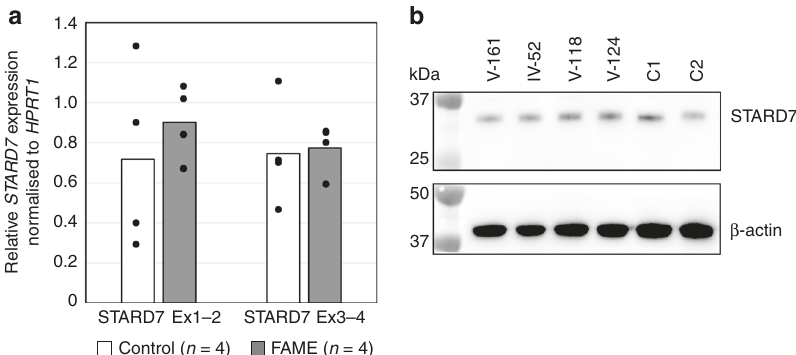
Fig. 3 Expression of STARD7 is unaltered in patient-derived skin fi broblasts. a Graph shows average STARD7 expression by relative standard curve quantitative PCR (qPCR) normalised to HPRT1 expression in fi broblast cell lines from four control donors (white bars) and four affected male individuals from Family 1 (IV-52, V-118, V-124 and V-161; black bars). Individual data points overlay the each bar. Tests for signi fi cance were performed using Student ’ s two-tailed t -test assuming unequal variances ( p = 0.50 Exon 1 – 2; p = 0.85 Exon 3 – 4). b Western blot of STARD7 protein compared to β -actin on the same blot of fi broblasts from the same four individuals from Family 1 as assayed by qPCR and two male control donors (C1 and C2). Data underlying this fi gure are available in